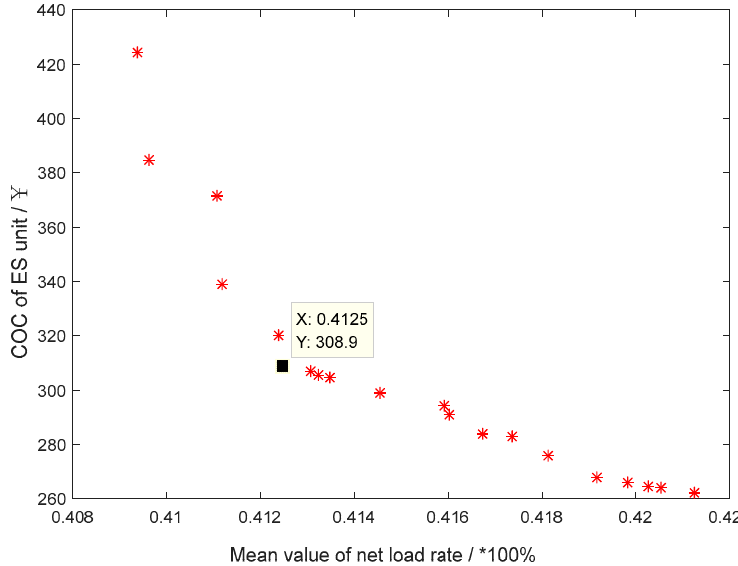
Figure 8. Pareto front of source-load level.